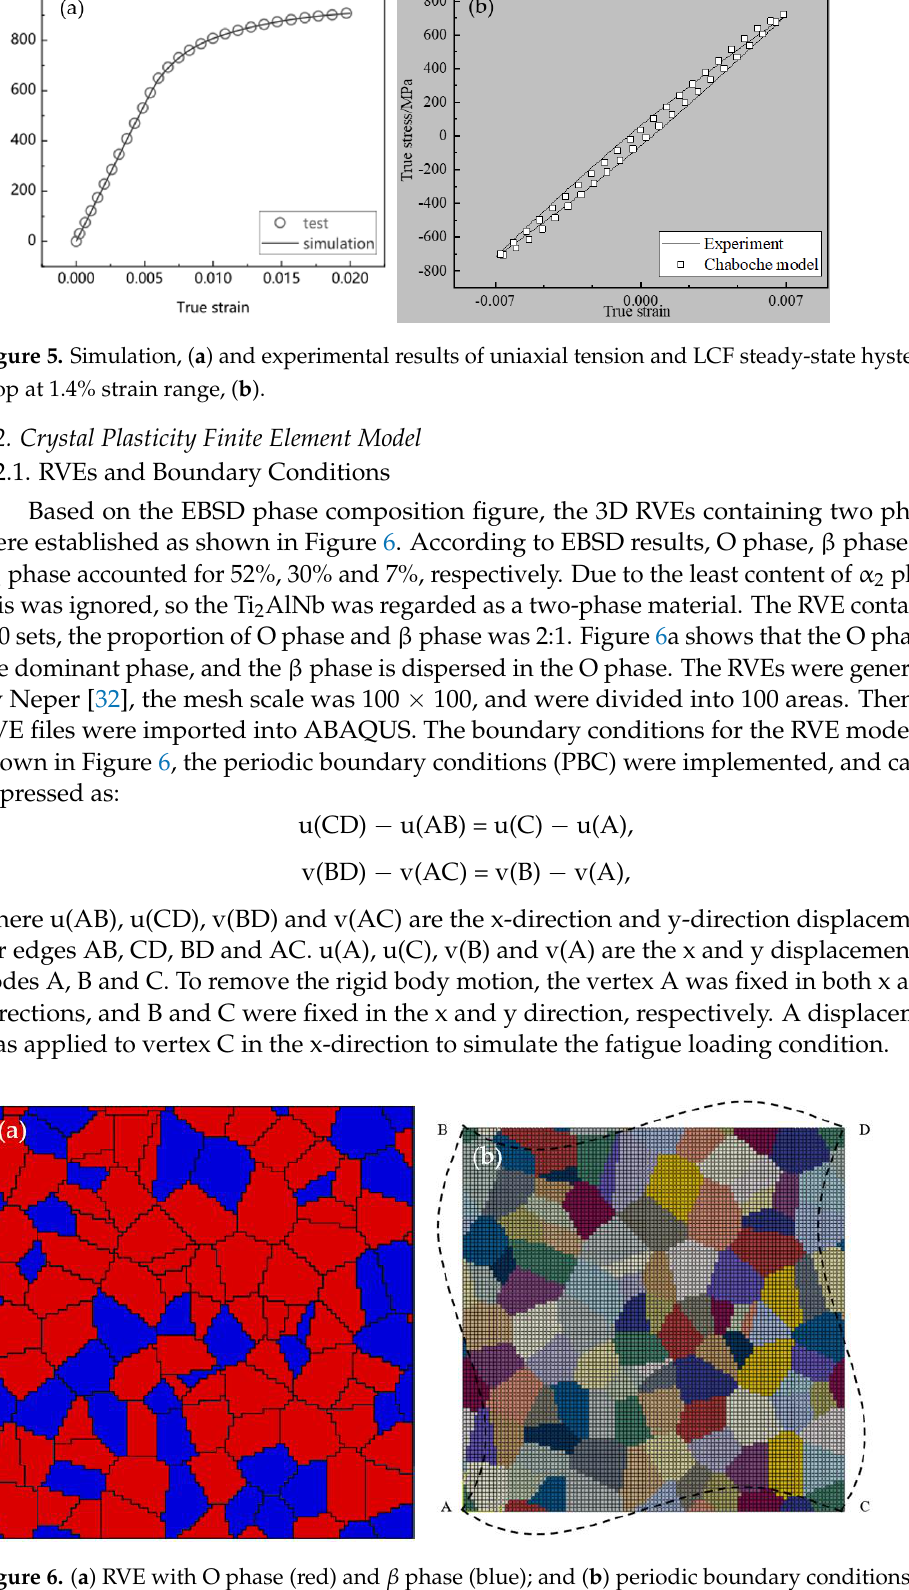
Figure 4. Element model and boundary condition.